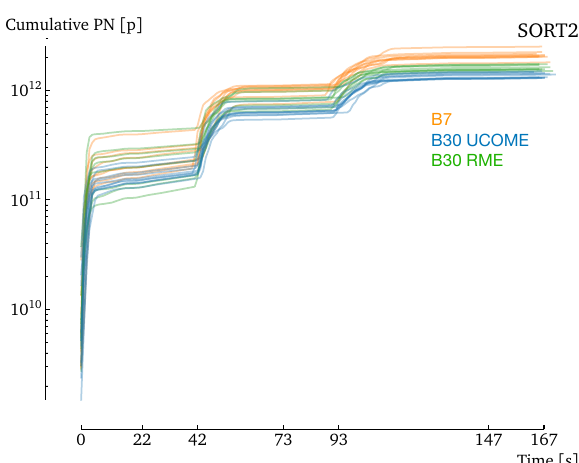
Figure 13. The cumulative PN emissions along the SORT 2 test runs indicate, alike for SORT 1, a decrease in PN emissions for B30 RME and B30 UCOME compared to B7.